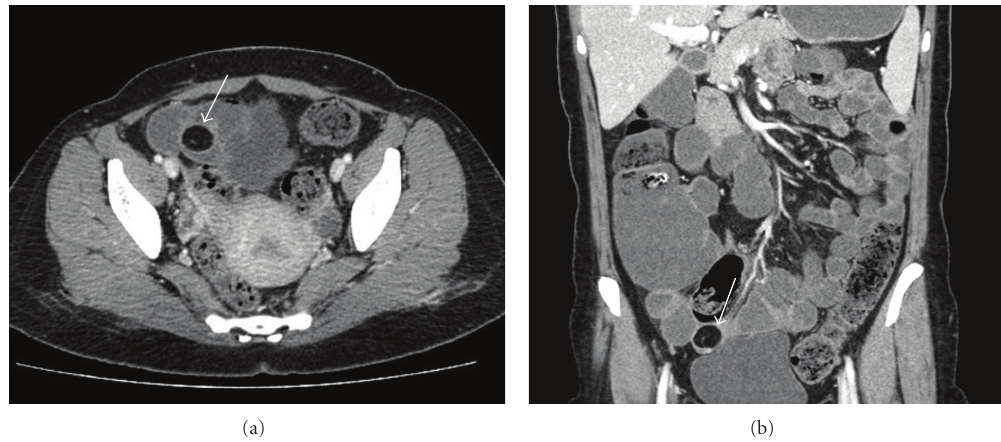
Figure 1: (a) Axial and (b) coronal plan contrast-enhanced CT scans demonstrate a well-circumscribed, intraluminal hypodense 25 × 20 mm mass with fat attenuation ( − 105 HU) in the terminal ileum (arrow). Any obvious sign of obstruction is not present on this CT.